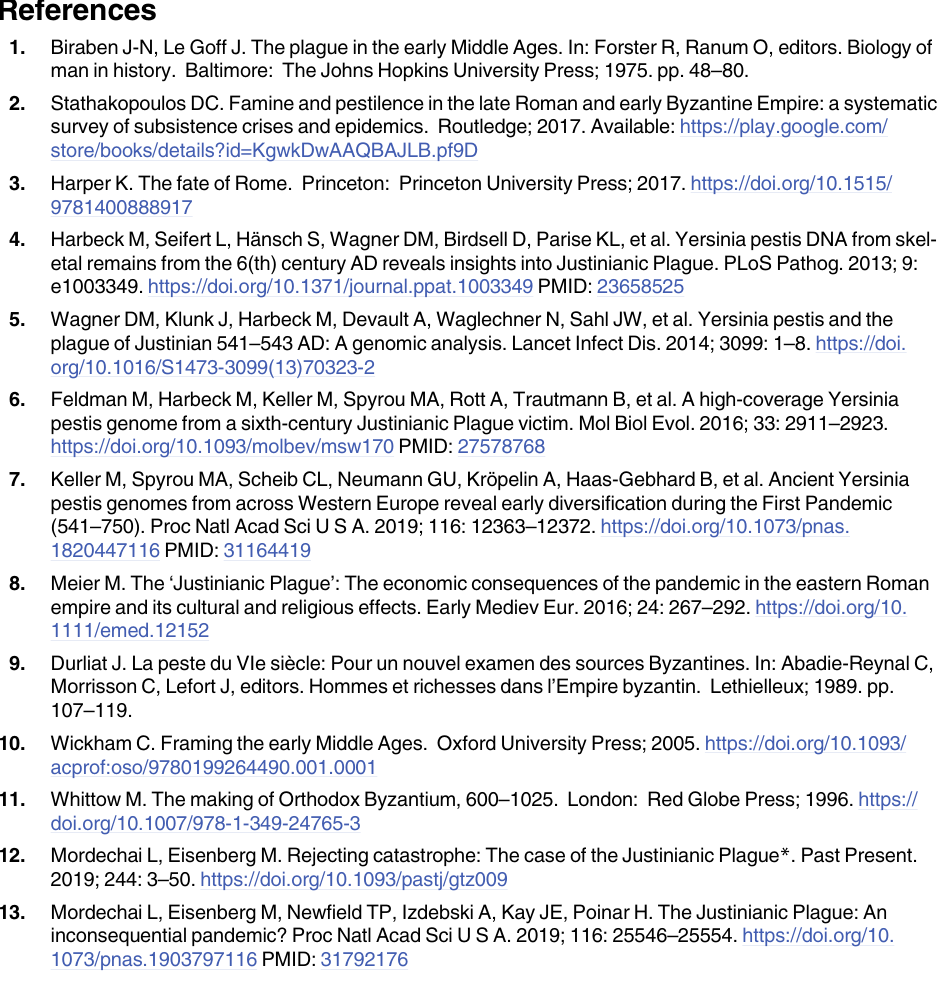
S1 Table. Summary of model output for each model type with rat to human ratio of 1:2. Outcomes include detectable outbreak duration, maximum mortality rate per day, and total